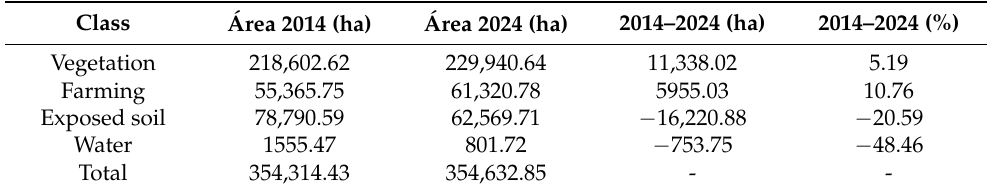
Table 5. Quantification of the future scenario of the municipality of Floresta-PE and comparison with